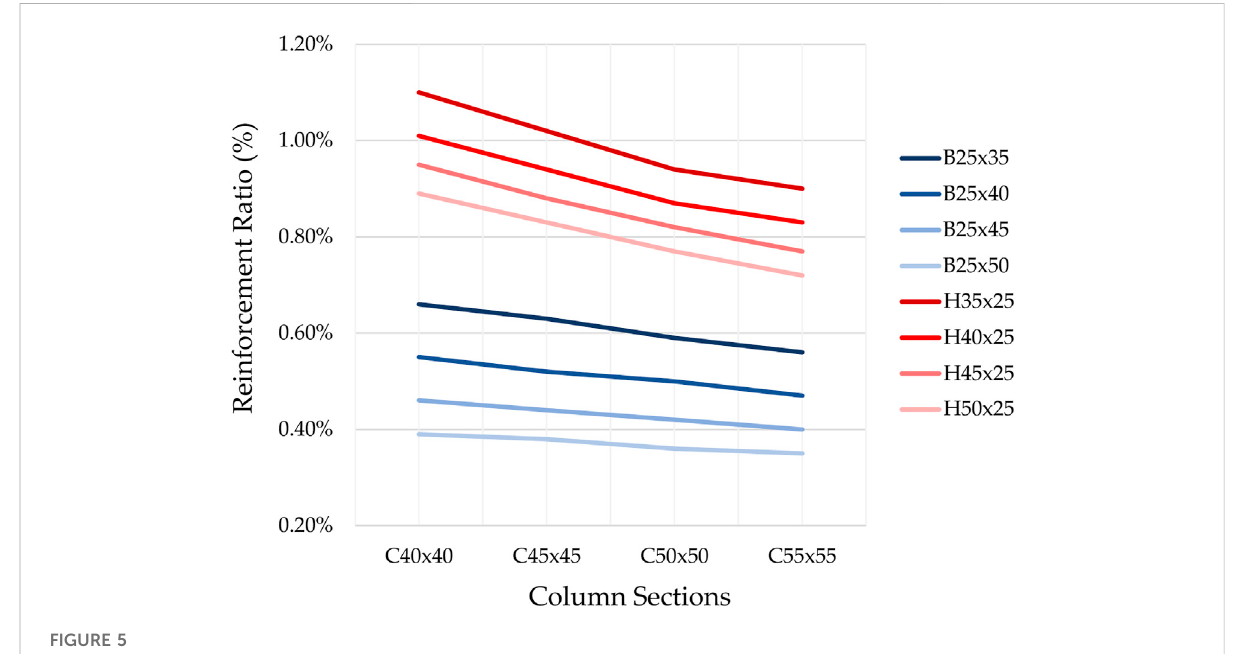
FIGURE 5 Required longitudinal reinforcement ratio.